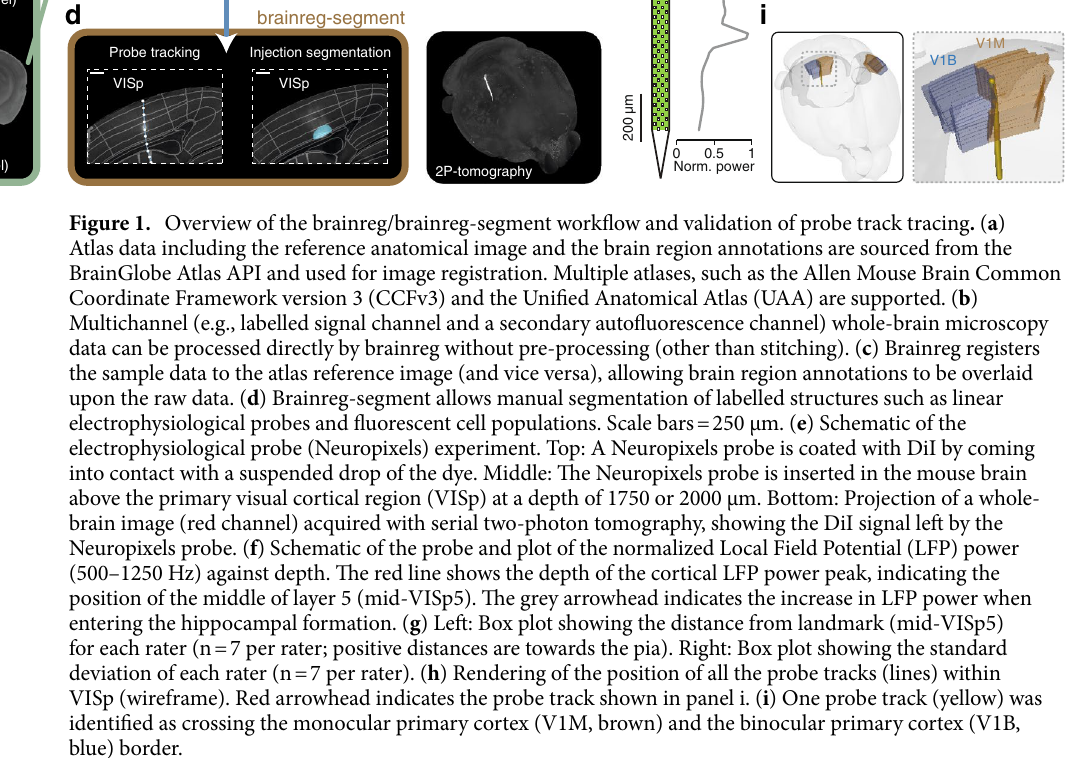
After recordings, a total of 7 brains were imaged using serial two-photon tomography 10 (Fig. 1e) and then pro- cessed with brainreg (CCFv3, 10 μm resolution). The experts were then asked to localise the silicon probe track using the brainreg-segment “Track tracing” function and the variability of track tracing was determined using the neocortical mid-layer 5 (mid-VISp5) as a “ground truth” landmark 11 (Fig. 1f). The average distance from mid-VISp5 (all raters: median = 57.4 µm, range = − 141.7–134.1 µm, n = 21) was not different between raters and was always below 84.5 µm (rater 1: median = 84.5 µm, range = − 135.9–134.1 µm; rater 2: median = 73.1 µm, range = − 141.7–90.3 µm; rater 3: median = 52.8 µm, range = − 120.8–90.6 µm; p > 0.05 Wilcoxon signed rank test; Fig. 1g). Interestingly, the direction of error from the landmark was positive in 17/18 cases suggesting that there is a systematic underestimation of the probe track length (median = 69.4 µm, range = − 5.4–134.1 µm, n = 18 exclud- ing outliers, see Methods; Fig. 1g). This likely reflects the difficulty of detecting the tip of the probe, resulting in experimenters tracing shorter tracks. We also found that while reliability differed between raters, it was always below an average of 17.4 µm SD (rater 1: median = 17.4 µm, range = 11.6–27.7 µm; rater 2: median = 11.7 µm, range = 4.1–27.8 µm; rater 3: median = 6.5 µm, range = 2.6–14.9 µm; p < 0.05 Wilcoxon signed rank test; Fig. 1g) and did not exceed 27.8 µm. These results show that, when compared to an electrophysiological “ground-truth” landmark (mid-VISp5), the accuracy of all raters was on average 69.4 µm. The accuracy and reliability were